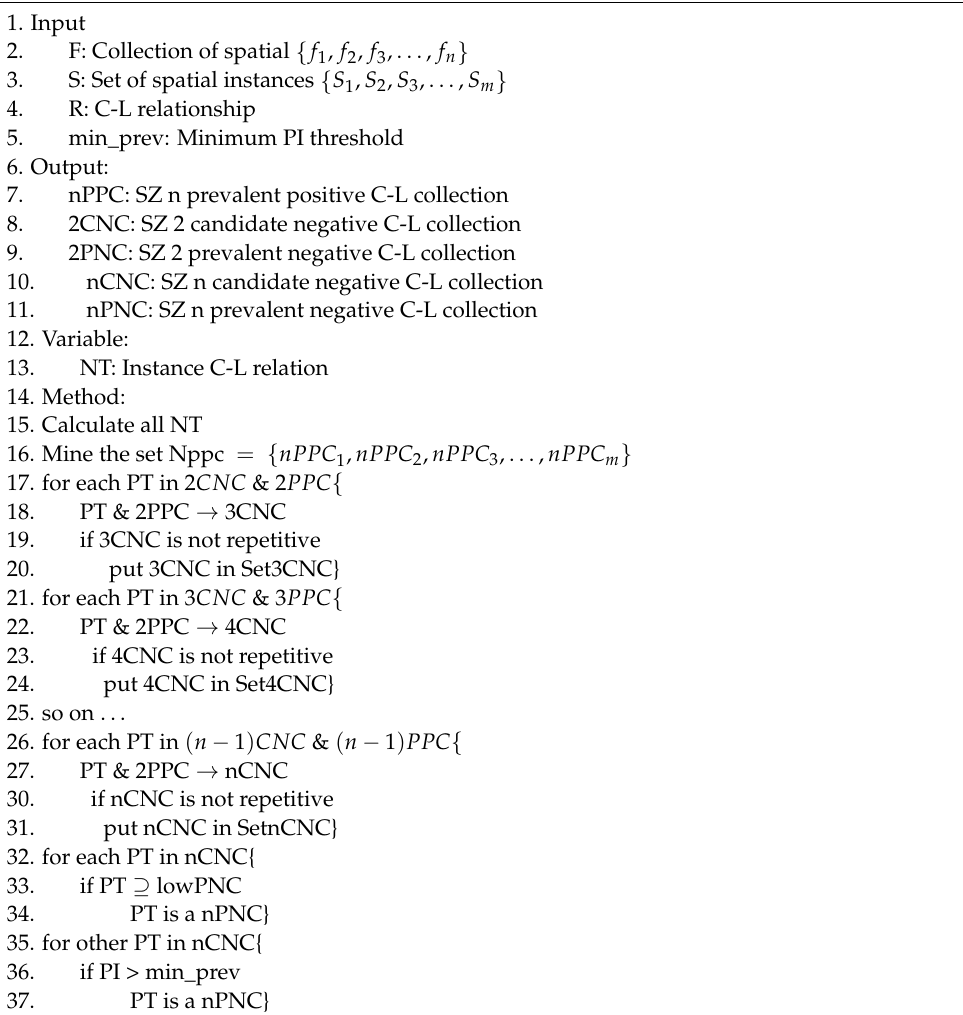
Algorithm 1: Join-based prevalent negative co-location pattern